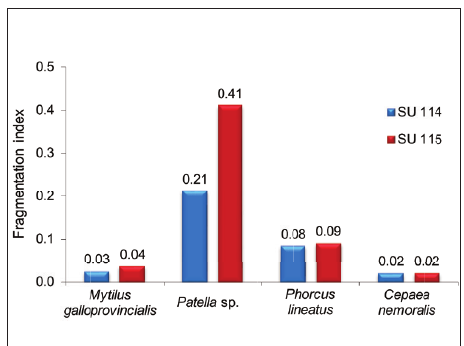
Figure 3: Fragmentation indices of the main species of molluscs (lower values reflecting higher